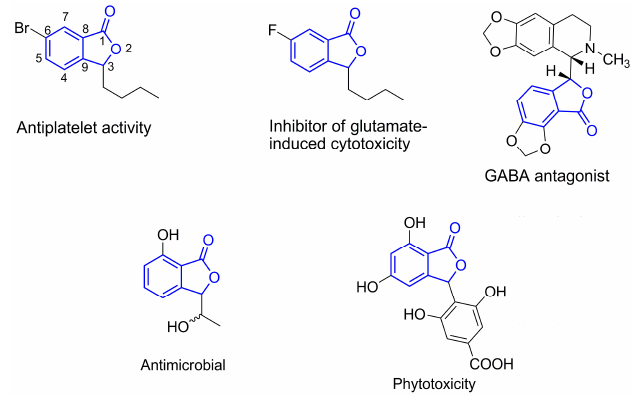
Figure 1. Example isobenzofuran-1(3 H )-ones and their biological activities.